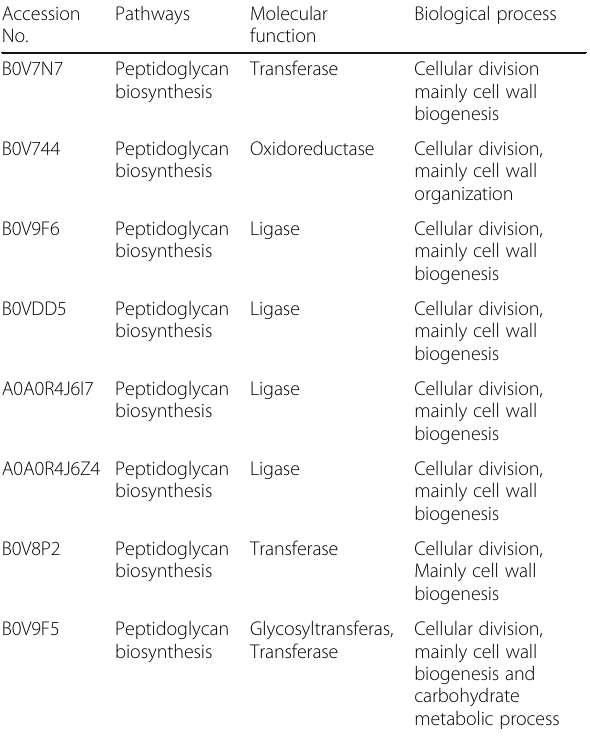
Table 1 The biological function of Mur proteins retrieved from UniProt database